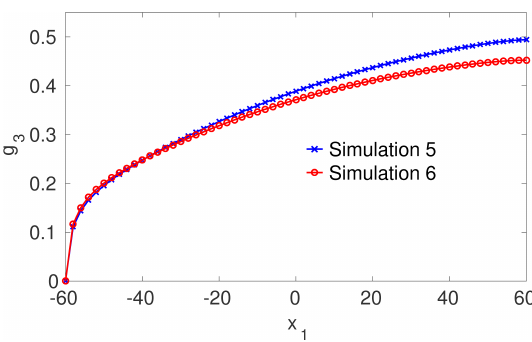
Figure 5. Profiles of g 3 = [[ u 3 ]] along x 1 at x 3 = 0 for simulations 5 and 6.